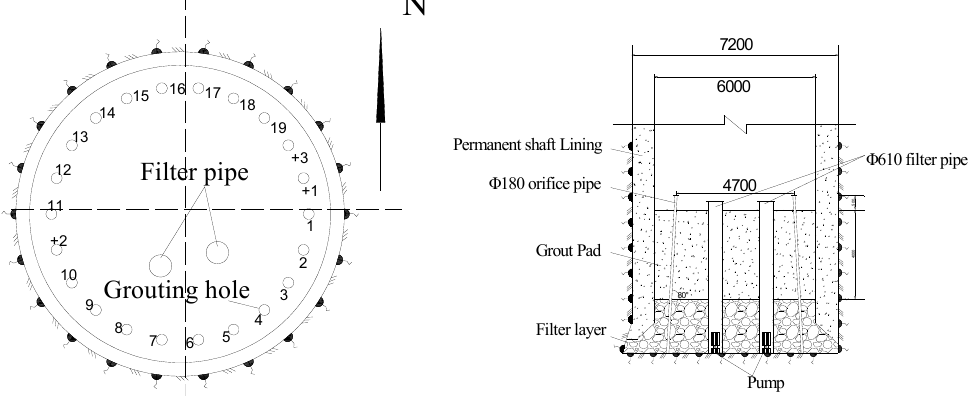
Figure 1 4. Layout of shaft pre-grouting construction. Figure 14. Layout of shaft pre-grouting